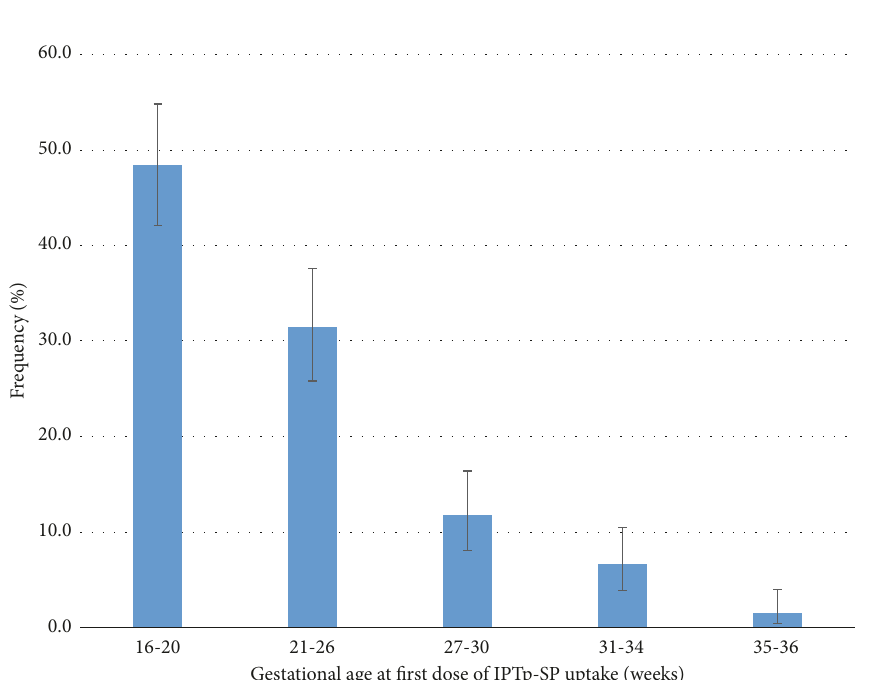
Figure 1: Gestational age at first ANC visit among women that had recently delivered at the Navrongo War Memorial Hospital in rural northern Ghana.